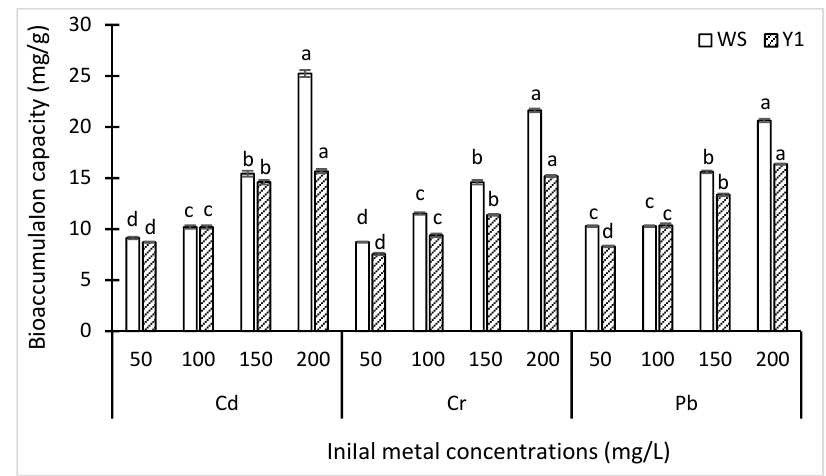
Figure 4. Influence of initial concentrations of Cd, Cu, and Pb on bioaccumulation capacities of five cells of Komagataella phaffi (WS) and Trichoderma harzianum (Y1). Bars indicate standard error of mean (±SE). Means values with same letters are not significantly different, calculated by Tukey’s honestly significant difference test.